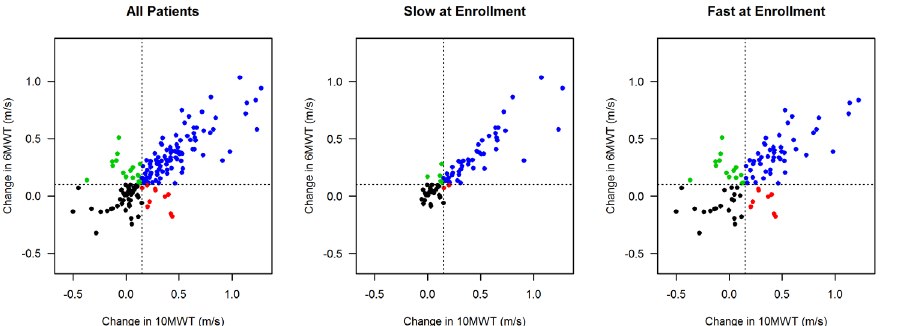
Figure 4. Enrollment-to-discharge improvements in 6MWT speed by enrollment-to-discharge improvements in 10MWT speed for all patients (n=170), patients that walked slow ( , 0.44 m/s) at enrollment (n=78), and patients that walked fast ( $ 0.44 m/s) at enrollment (n=92). Plots restricted to patients that had enrollment and discharge evaluations of the 6MWT and 10MWT. Dotted lines are plotted at the MCID for the 6MWT (0.10 m/s) and 10MWT (0.15 m/s). Blue=improvements exceeded MCID for both 6MWT and 10MWT, red=improvements exceeded MCID for 10MWT only, green=improvements exceeded MCID for 6MWT only, black=improvements did not exceed MCID for either 6MWT or 10MWT.